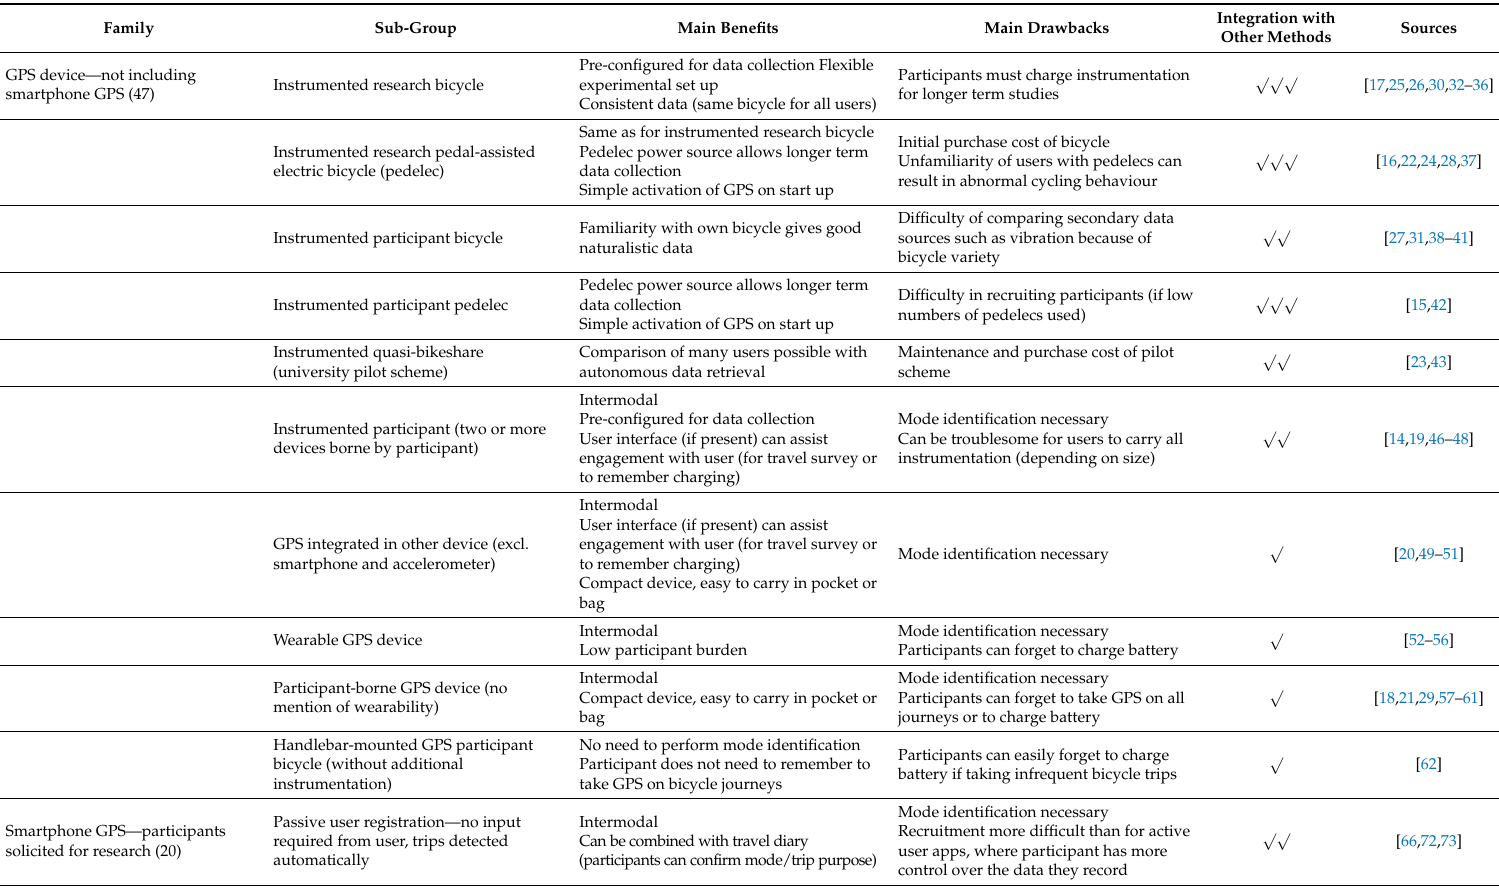
Table A1. Classification of the 112 empirical studies based on principal route choice methods used into family and primary method